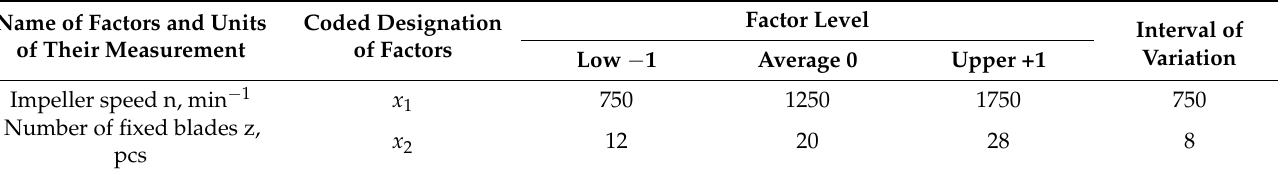
Table 1. Plan of the experiment to determine the optimal parameters 2.